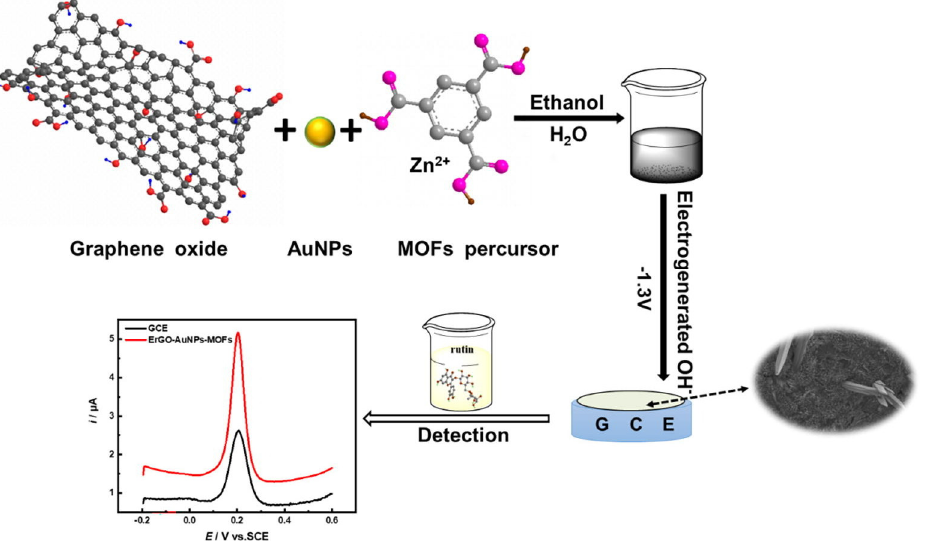
Figure 23. Assembliy of ErGO-AuNPs-MOFs/GCE as rutin electrochemical sensor. Reprinted with permission from [168]. Copyright 2021, Elsevier.